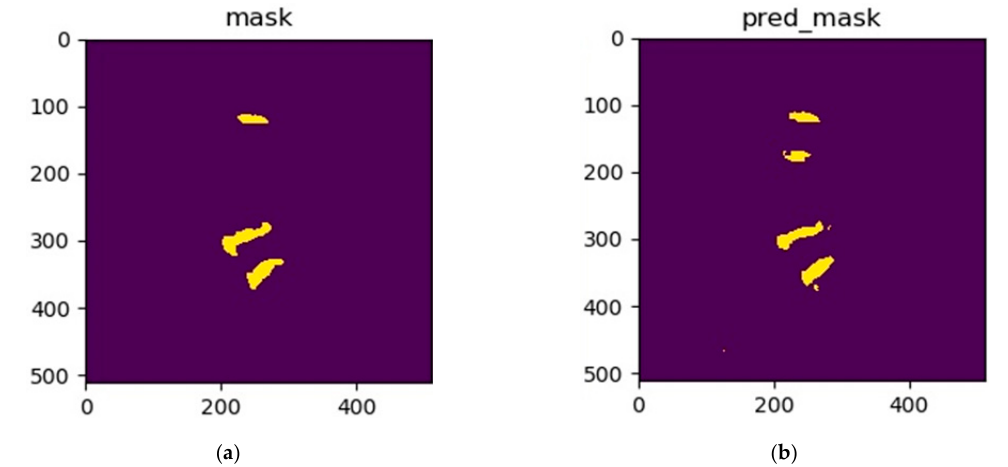
Figure 2. An example of a segmentation error: ( a ) the standard masks of the three intervertebral discs; ( b ) the segmentation error of a redundant intervertebral disc using the MultiResUNet model.